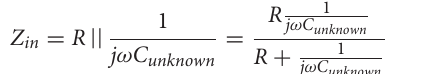
( Figure 7 ), capacitance characteristics (inductive susceptance, X C 2 π fC unknown ) are computed by keeping resistance in = parallel. Zin (input impedance) is evaluated and unknown capacitance ( C unknown ) is measured as expressed in Equation (11) and simulated in the EM structure. The measurement is plotted with real values of capacitance in